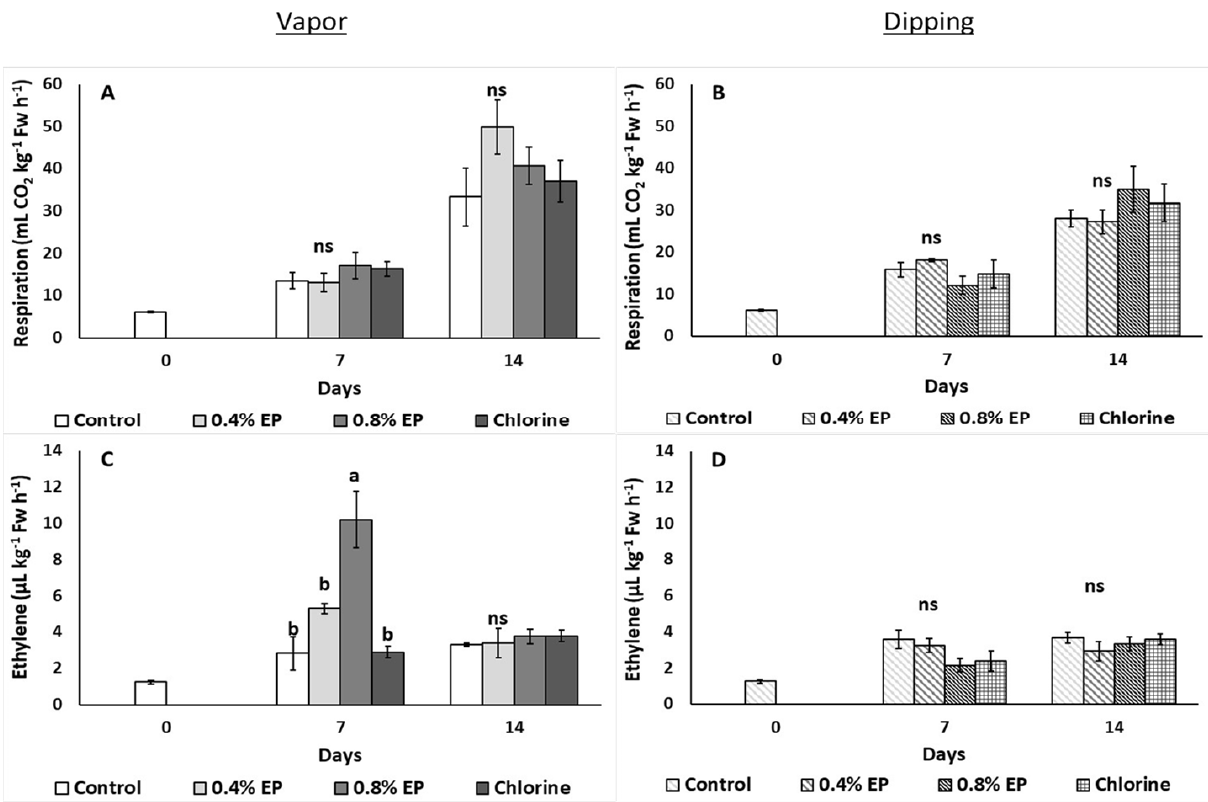
Figure 3. Effects of vapor ( A , C ) or dipping ( B , D ) application with eco-product (EP) at different concentration (0–0.4% and 0.8%), chlorine (0.02%) or control (application with water) on respiration rate (mL CO 2 kg − 1 Fw h − 1 ) and ethylene production ( µ L kg − 1 Fw h − 1 ) of cucumber fruits stored at 11 °C and RH ~90% up to 14 days. Means ± SE followed by different Latin letters are significantly different according to Duncan’s MRT ( p = 0.05). ns: not significant.